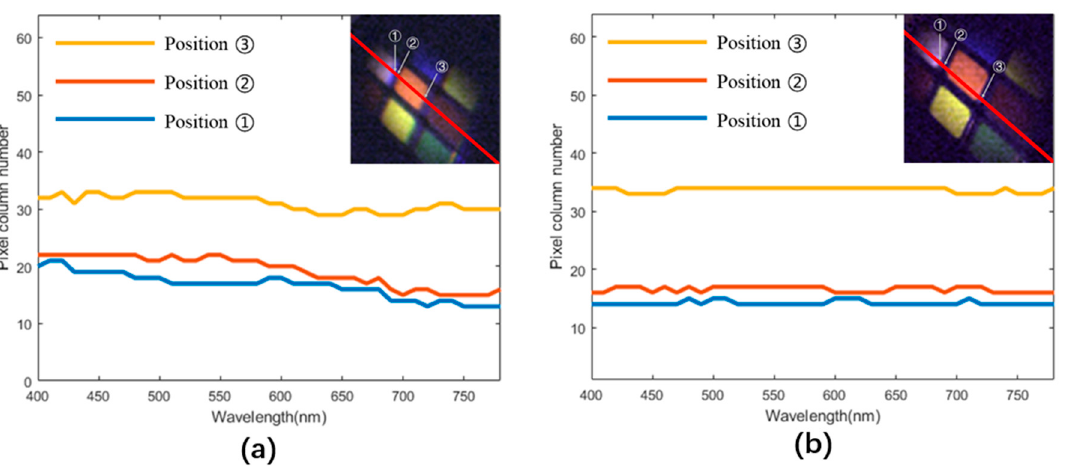
Figure 10. Pixel column number of the ① , ②, and ③ positions vs. wavelength over 400–780 nm for the control group ( a ) and the TV lens group ( b ). A flat line indicates no deviation in the focal point position, i.e. no lateral chromatic aberration occurs.